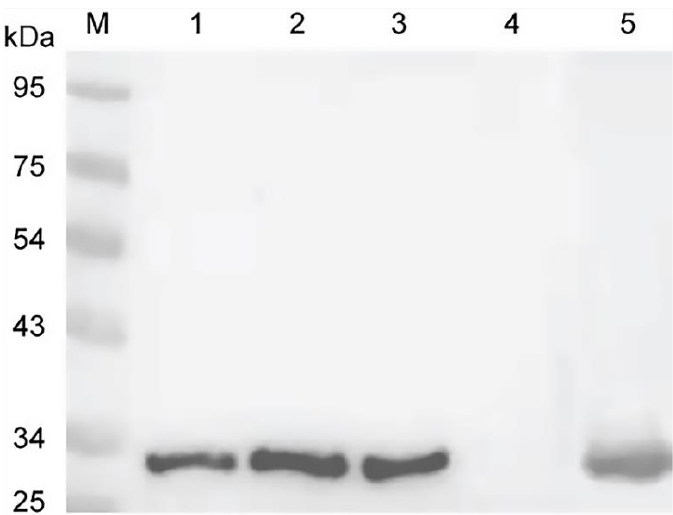
Figure 2. Immunoprecipitation showing the human C1q was pulled down by the native Em CRT from worm extracts or vesicle fluid and detected by rabbit anti-C1qA antibody: M, standard protein marker; Lane 1, extracts of metacestode vesicles + anti- Em CRT + C1q; Lane 2, metacestode vesicle fluid + anti- Em CRT + C1q; Lane 3, extracts of PSCs + anti- Em CRT + C1q; Lane 4, anti- Em CRT + C1q; Lane 5, human C1q alone (5 µg).